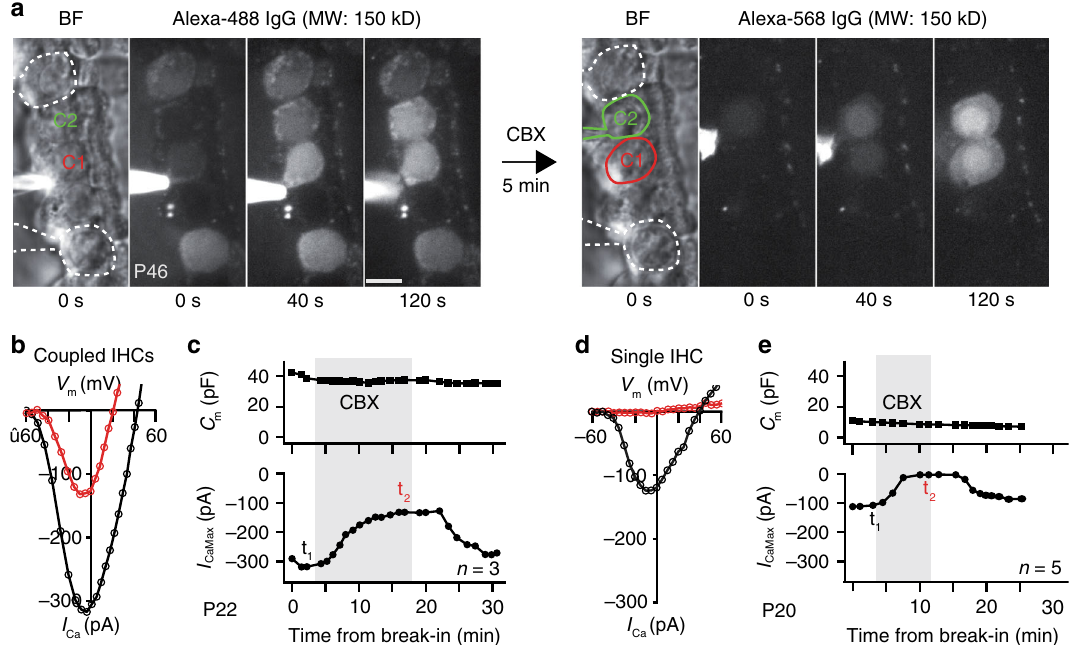
Fig. 4 Molecular and electrical IHC coupling is not prevented by the GJ blocker CBX. a The left time series of green fl uorescence shows how Alexa-488 conjugated antibodies diffuse from the targeted IHC (delineated in red, C1) to the coupled IHC (delineated in green, C2). Two of the surrounding uncoupled IHCs (highlighted by white lines) have previously been loaded with the antibodies. After retracting the pipette, CBX (250 µ M) was added to the bath solution fi ve minutes prior to the loading of Alexa-568 conjugated antibodies via patching C2. The right time series of red fl uorescence (same length scale as in a ) shows that the spread of Alexa-568 conjugated antibodies to C1 is not blocked by CBX. Surrounding SCs, especially inner pillar cells, exhibit auto- fl uorescence. b – e Ca 2 + -current voltage (IV) curves were obtained by depolarizing IHCs from the holding voltage ( − 60 mV) with 5 mV steps before and during bath application of CBX. The presence of CBX is marked with gray in the membrane capacitance (C m )-time and maximal I Ca ( I CaMax )-time plots. The recording time points of the presented IV curves are marked with t 1 (for black curve) and t 2 (for red curve) in the I CaMax -time plots. The experiments were stopped when the patched IHC was lost. CBX inhibits I Ca of coupled IHCs without changing C m , as seen in with single IHCs. CBX carbenoxolone, V m membrane voltage. Scale bar: a = 5 µ